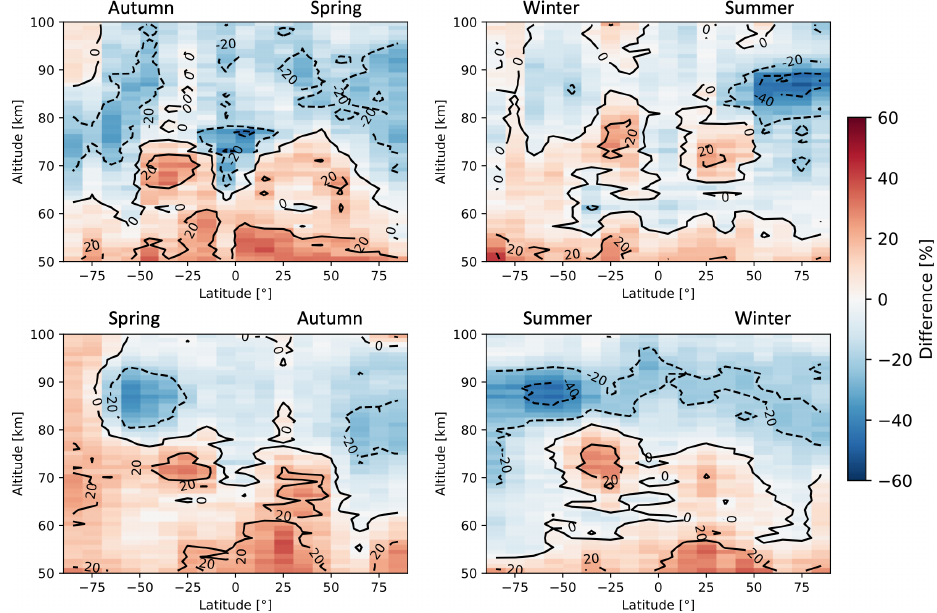
Figure A3. Seasonal zonal means of SMR–MIPAS upper atmosphere relative differences averaged over the time period indicated in Table 2. The seasons are intended as the time between the solstice and the equinox.